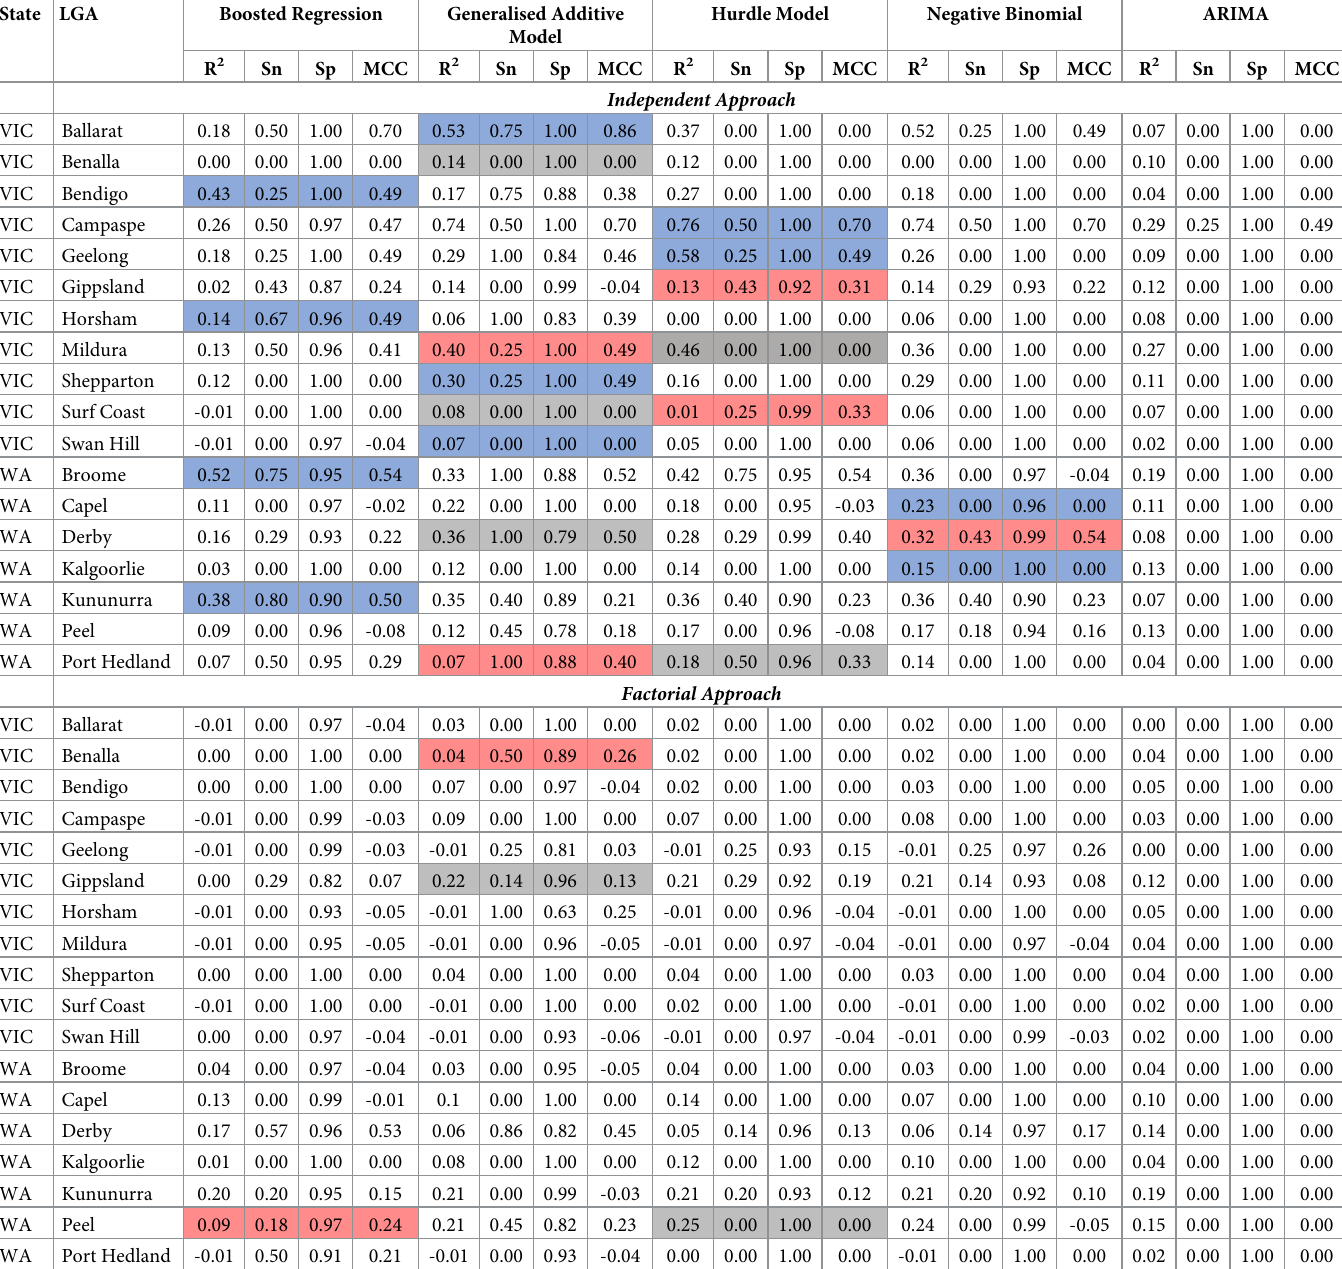
Table 2. Independent and Factorial Approach results by State; Victoria (VIC), and Western Australia (WA) and local government area (LGA) for predicting RRV notifications per 100,000 population (R 2 ) and outbreaks (Sn, Sp and MCC). Adjusted R-squared coefficient (R 2 ), sensitivity (Sn), specificity (Sn), and Matthews correla- tion coefficient (MCC) of model performance and predictions. Shading represents the best fit statistical model for predicting notifications (grey); predicting outbreaks (red): and predicting both outbreaks and notifications